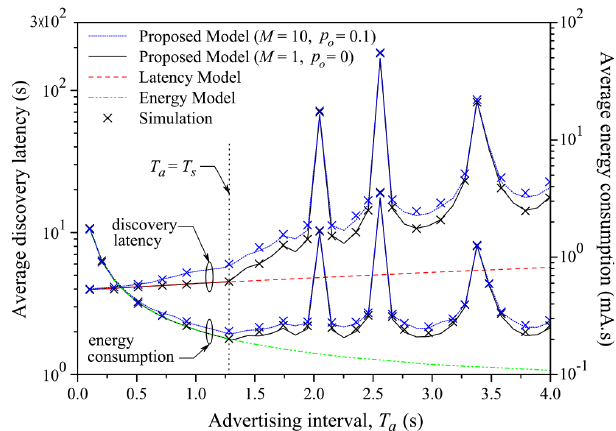
Figure 16. Average discovery latency and energy consumption of the advertiser according to T a ( T s = 1.28 s and T = 10.24 s) [78]. The green line shows the model proposed by [76], while the black and blue lines positioned in the lower part show the models analyzed in [78]. The crosses represent the simulation based on the theoretical model. As can be noticed, when T a > T s , the two results do not agree anymore. On the other side, the red line [79] and the two blue and black lines positioned in the upper part of the figure represent the data relative to the latency, analyzed in Section 3.4. M is the number of pairs of scanners and advertisers existing in the communications, while p 0 is the failure probability due to the interference with other devices. Adapted from [78].